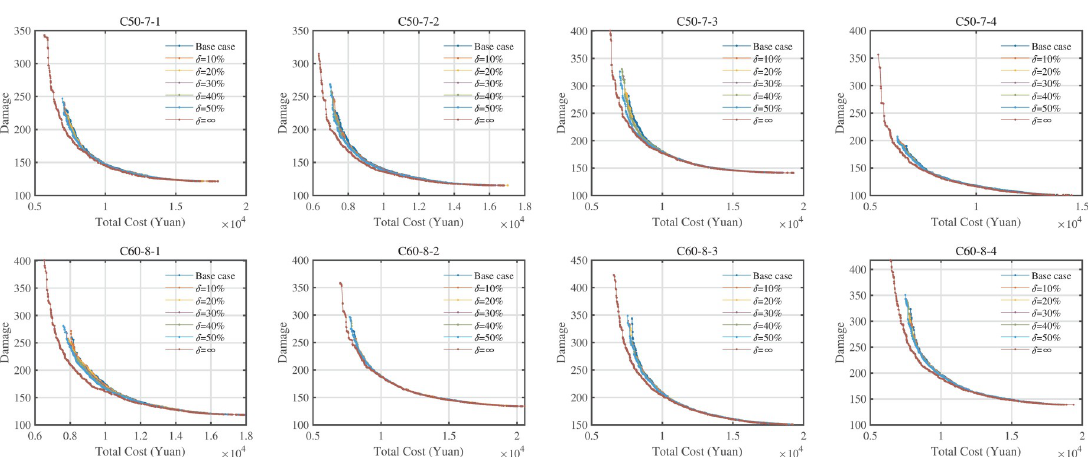
Fig 10. Pareto fronts of seven variants of hard time windows of clients.